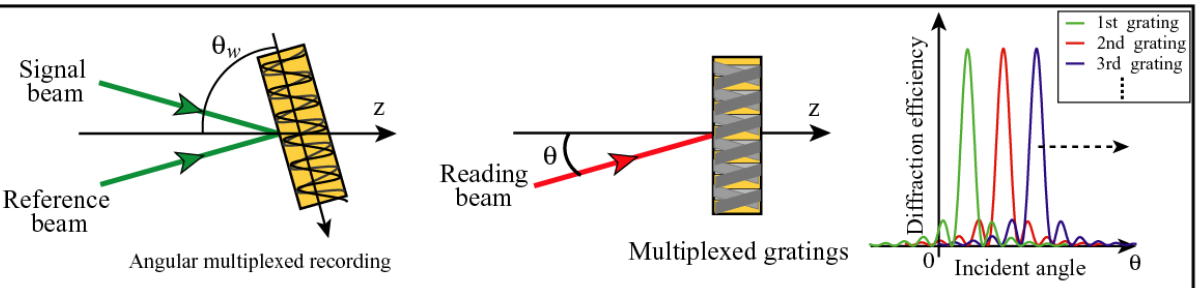
Figure 11. Angular multiplexed holographic gratings in a thick